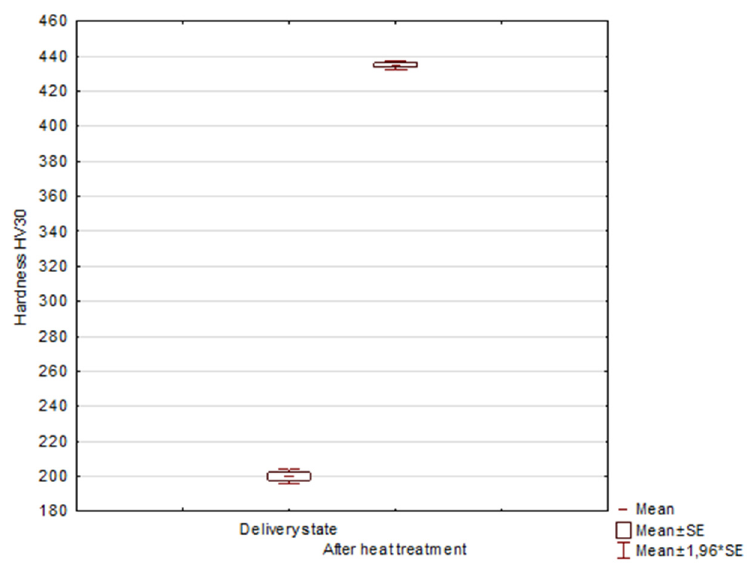
Figure 11. Box-and-whisker plot showing the significant effect on the increase in hardness values of the steel after heat treatment.